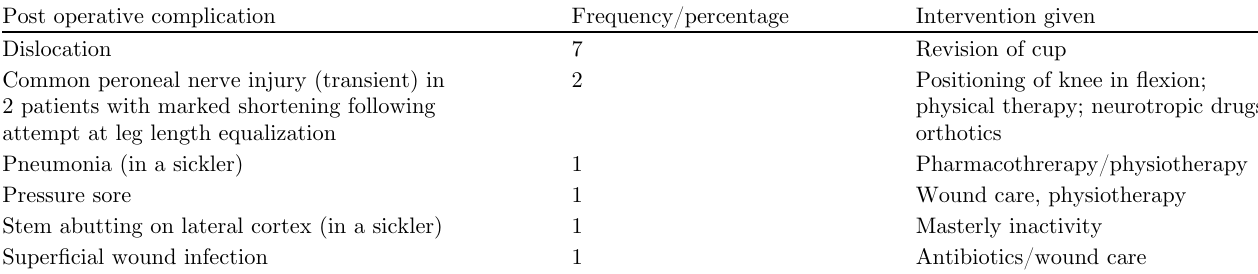
Table 3. Post operative